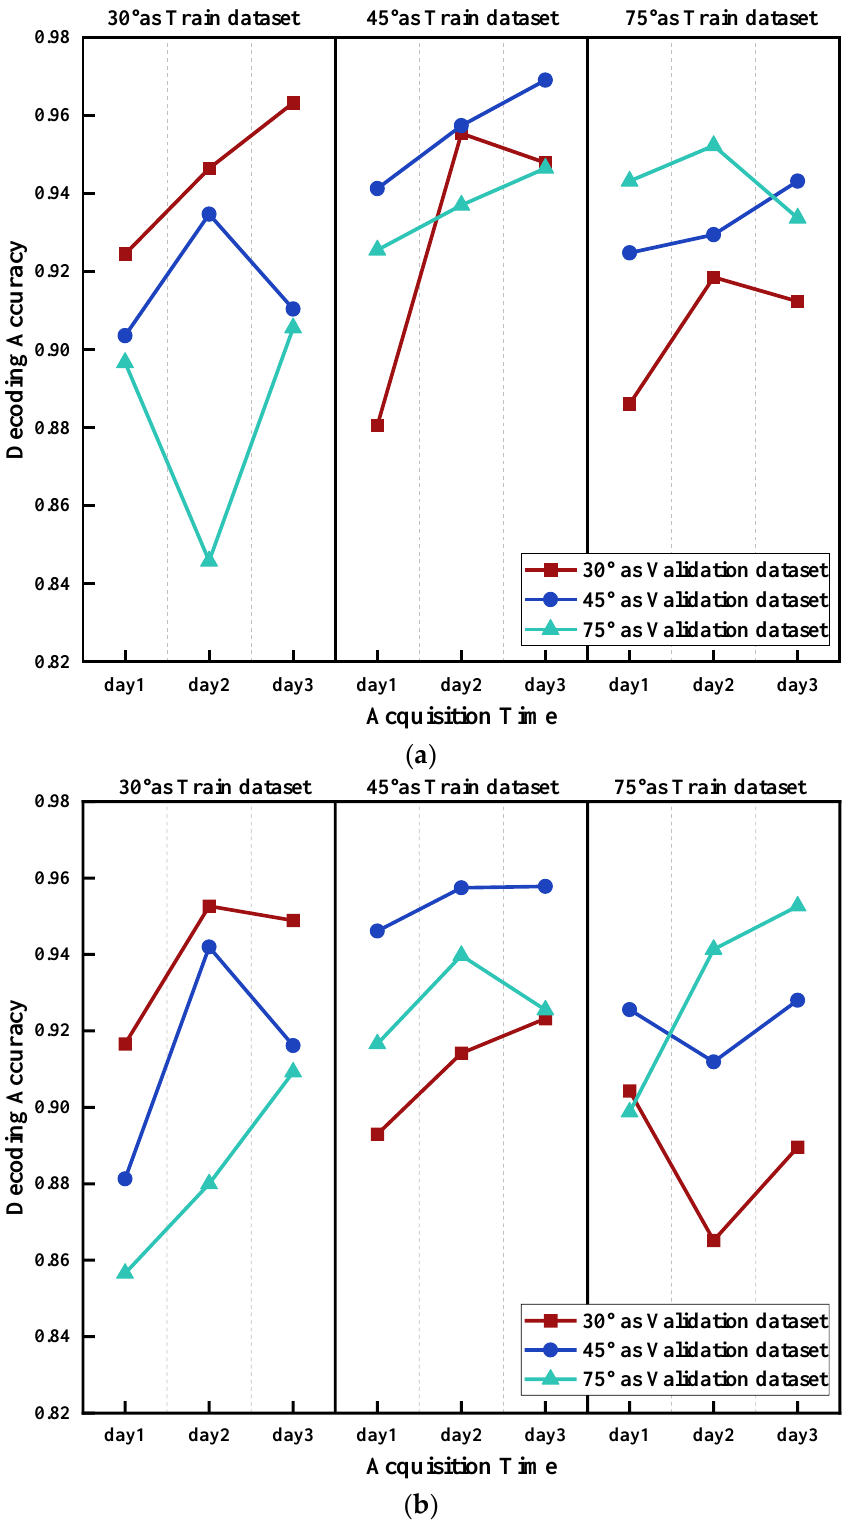
Figure 10. Influence of forearm angle on the accuracy of gesture decoding. 30° as validation dataset, 45° as Validation dataset and 75° as Validation dataset means using Class 30° , Class 45 ° and Class 75° to test the trained model, respectively. ( a ) Influence of forearm angle using LDA; ( b ) Influence of forearm angle using PNN.